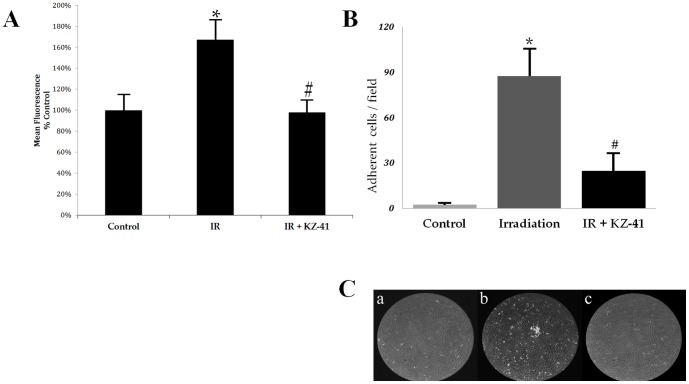
Radiation-induced REC-U937 adhesion.Panel A) Static-adhesion: Irradiated human RECs were incubated for 24 hours in culture medium containing vehicle (PBS) or KZ-41 (10 µM). Calcein-AM loaded U937 cells were co-cultured with RECs (n = 8/group) for 30 minutes and non-adherent cells were washed from wells; attached U937 cells were quantified with a fluorescence microplate reader (excitation/emission wavelengths of 485/535 ηm). Data demonstrate that KZ-41 inhibits IR-induced leukocyte attachment to RECs (*, **P<0.005) (All data normalized to background fluorescence; data represent % Control fluorescence signal ± SD). Panel B) Flow-Chamber adhesion: RECs were irradiated and cultured for 24 hours. U937 cells were perfused over RECs placed in flow-chamber and digital images were collected after two hours. Data represent mean #-adherent cells/field ± SD. KZ-41 (10 µM) treatment significantly decreased IR-induced adhesion of U937 cells (*, #P<0.05). Panel C) Representative still images A) Control, B) IR-REC and C) IR+KZ-41 show extent of U937 accumulation on surface of RECs.